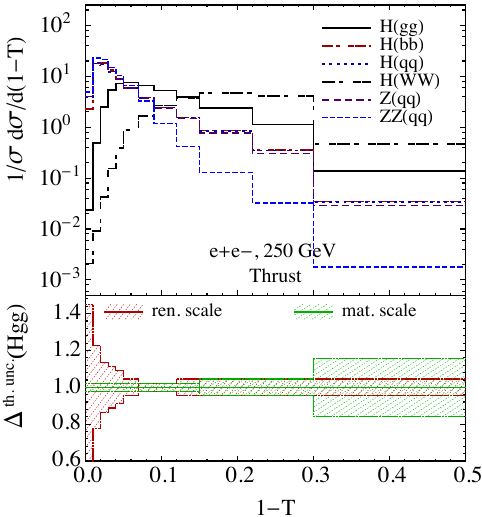
Figure 1 . Normalized distributions of thrust in hadronic decays of the Higgs boson, in e + e − with a CMS energy of 125 GeV and in e + e − later two cases the thrust is calculated in the hadronic CMS frame. The lower panel shows the relative theoretical uncertainties of the normalized distribution for H of renormalization and matching